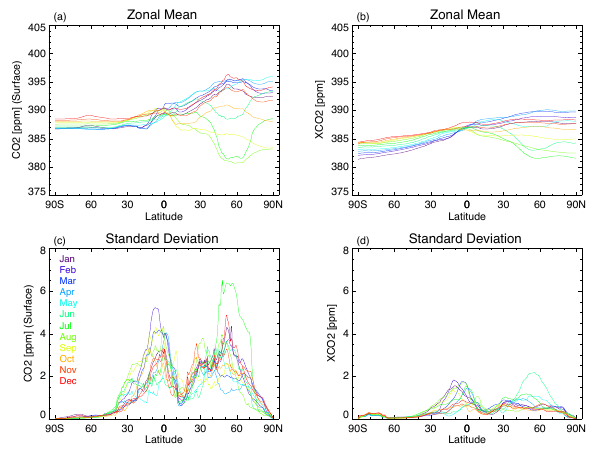
Fig. 12. Monthly zonal-mean latitudinal distributions of (a) CO 2 and (b) XCO 2 for 2010 and (c–d) their standard deviations against longitudinal variation.